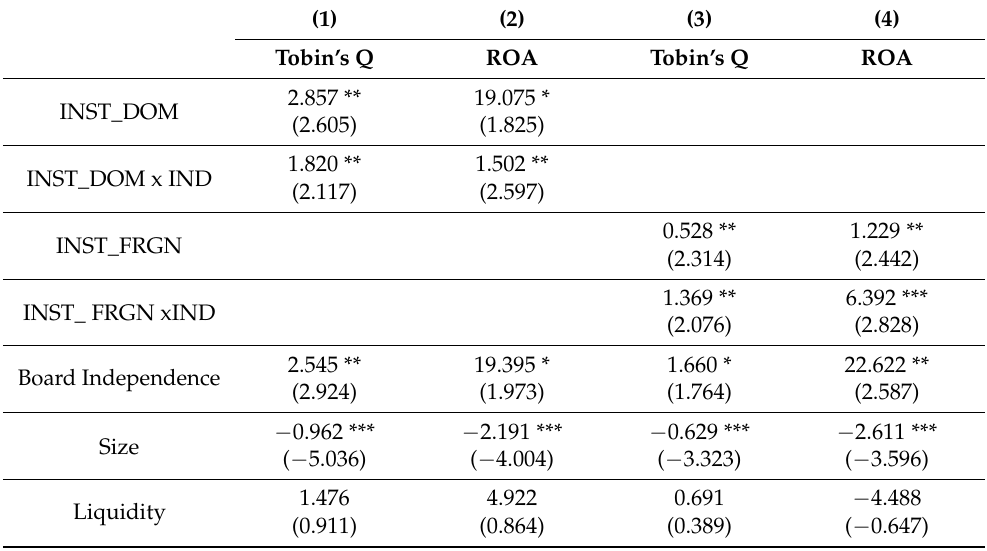
Table 7. Mediating impact of Board Independence on the relationship between institutional owner- ship and firm